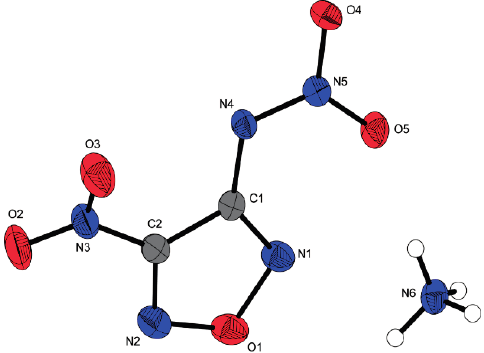
Figure 5. Molecular unit of 6 . Ellipsoids are drawn at the 50% probability level.